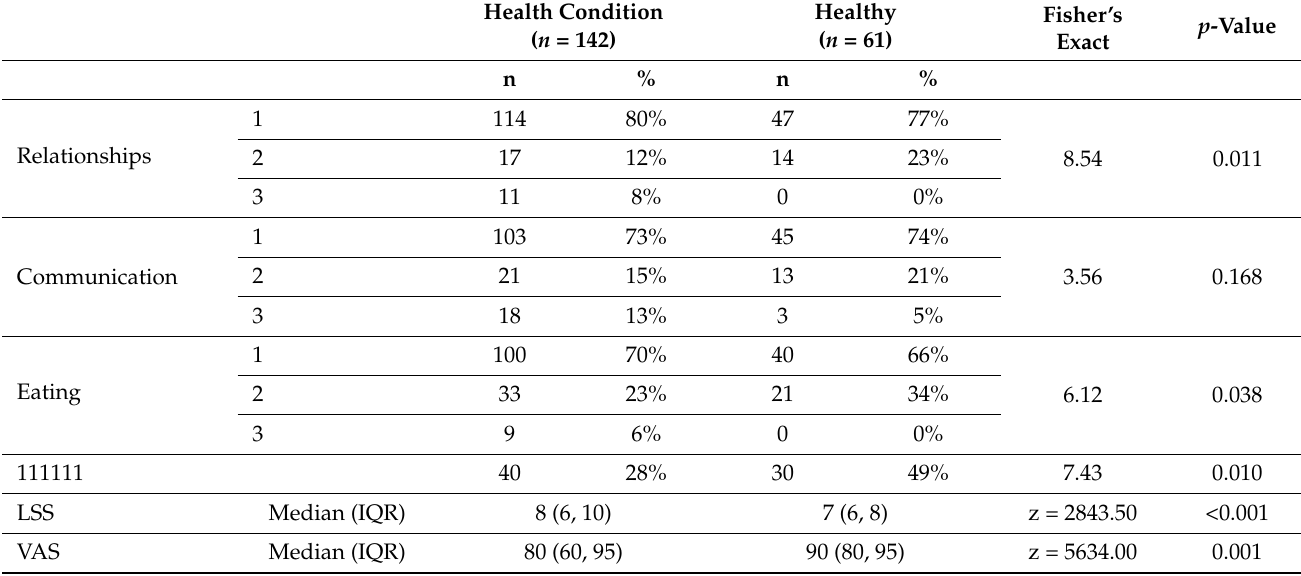
Table 2. Cont . Health